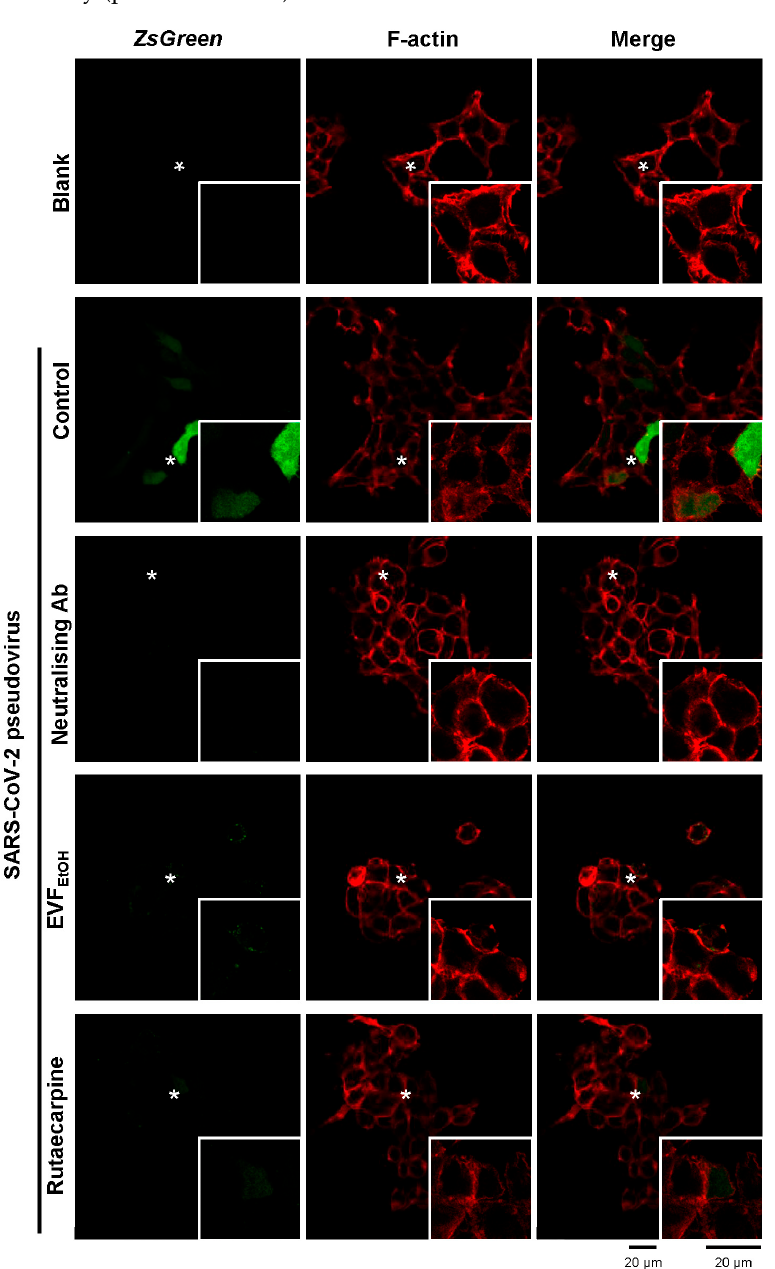
Figure 6. Representative confocal images showing that EVF EtOH and rutaecarpine prevent pseudo- virus entry into cultured HEK293T cells. The pseudovirus expressed ZsGreen which generated green fluorescence (color green in the figure) inside cells, and fluorescent phalloidin (color red in the figure) was used to stain the F-actin component of the cell membrane. Prior to exposure to the pseudovirus, cells were either untreated (control) or were treated with a SARS-CoV-2 neutralising antibody (1 µ g/mL; positive control), or with EVF EtOH (0.1 mg/mL) or rutaecarpine (100 µ M). The fluorescence intensity was significantly decreased following treatment with EVF EtOH or rutaecarpine compared with the untreated controls. In each panel, the region indicated by the asterisk is shown at higher magnification in the inset image. For each treatment n =